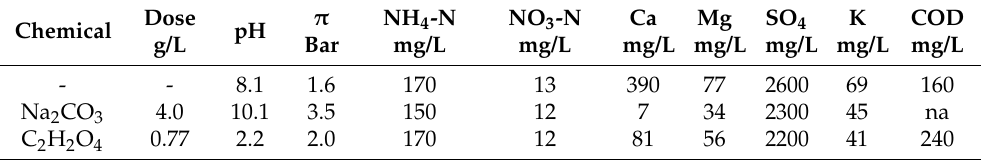
Table 3. Feed water samples for nanofiltration (NF) and seawater reverse osmosis (SWRO).